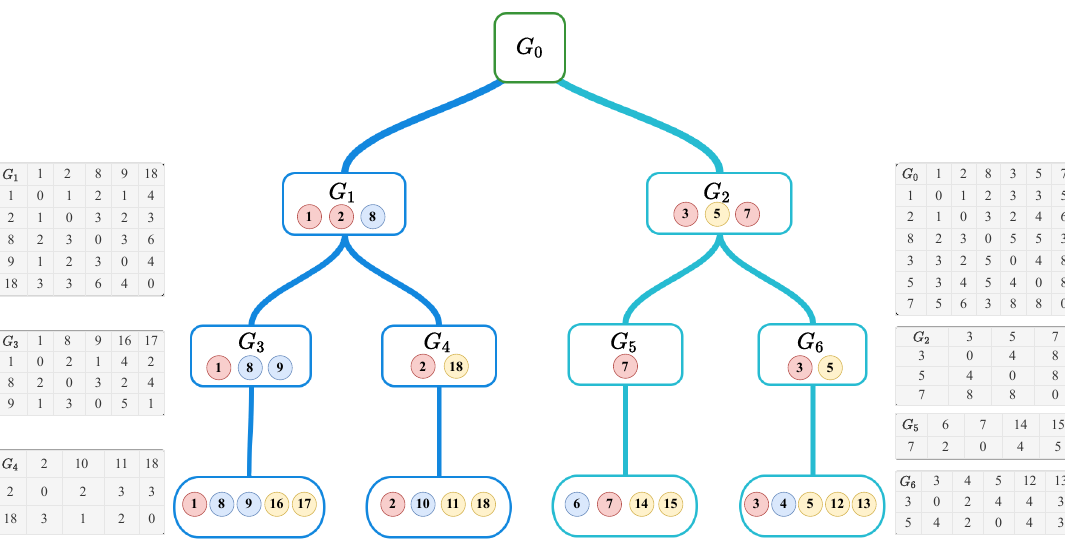
Figure 4. An example of BVCP